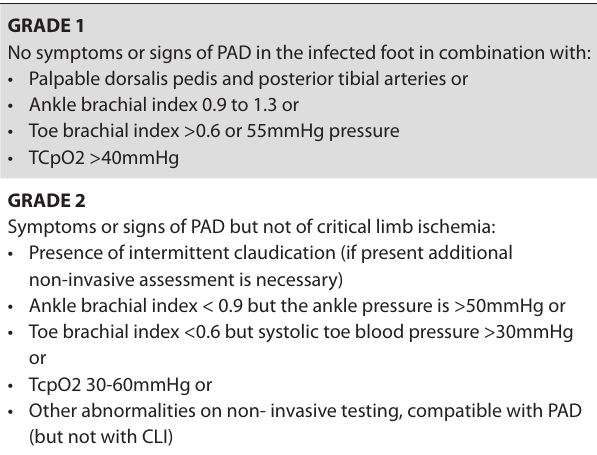
Grading of the diabetic foot adapted from